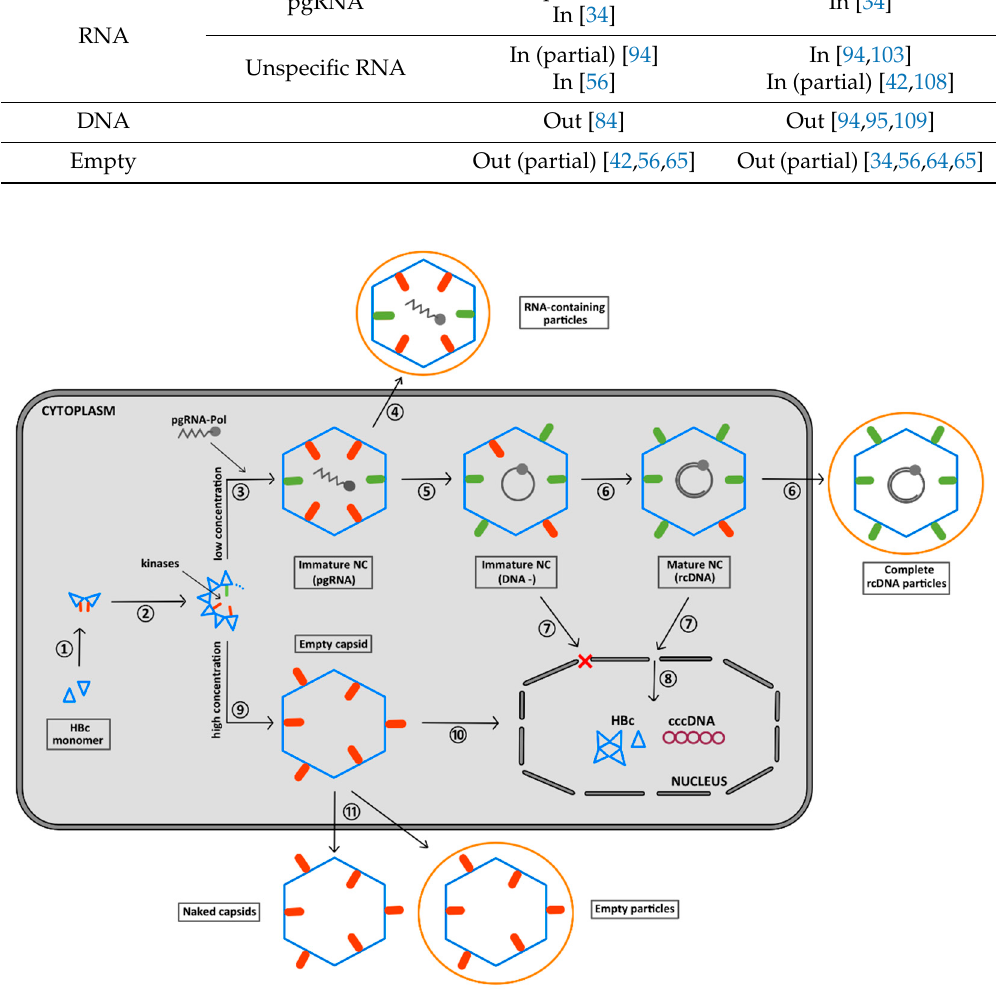
Figure 10. Phosphorylation and CTD exposure during HBV replication. CTD localization is presented inside and outside capsids as small rounded bars. Phosphorylated CTDs are in red, while unphosphorylated CTDs are in green. Numbers correspond to the different steps during which phosphorylation and/or CTD flips possibly occur.